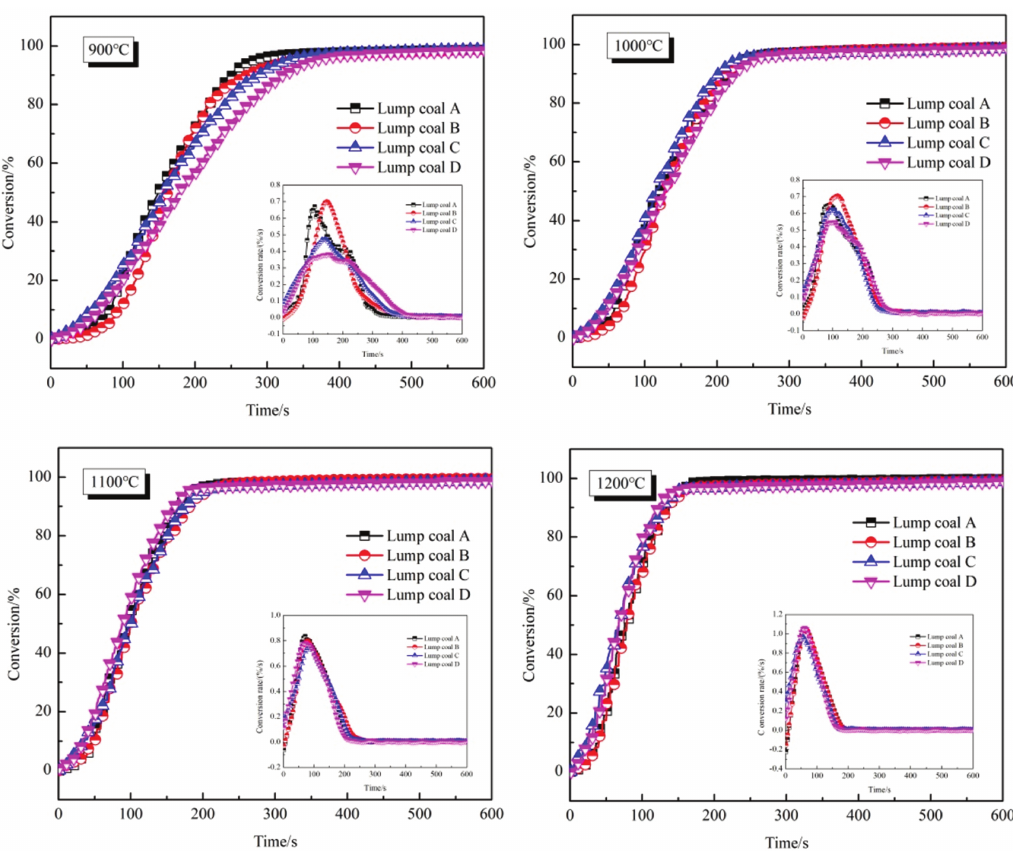
Figure 7: Compared analysis of the pyrolysis behaviours of lump